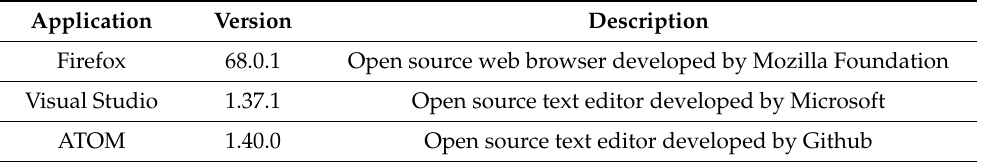
Table 6. Applications tested for measuring the launch time.